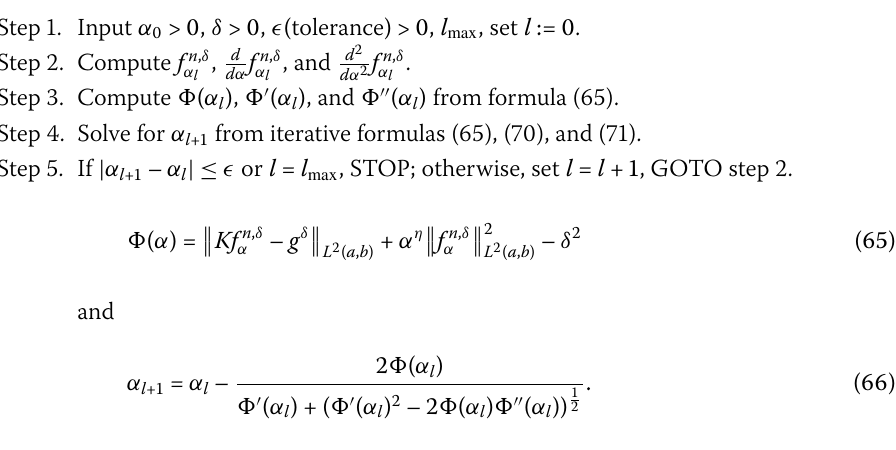
Algorithm of the cubic Morozov discrepancy principle